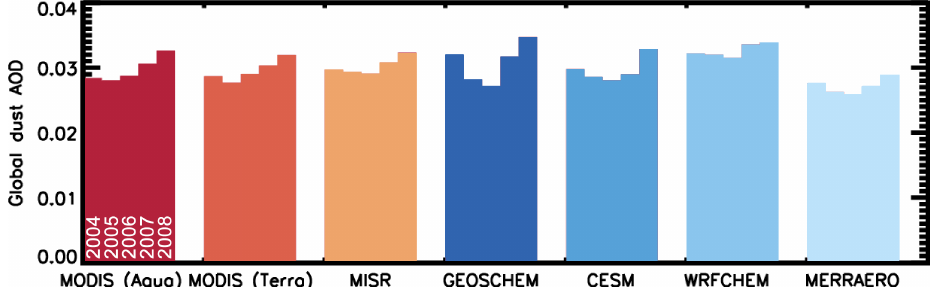
Figure 4. Annual global dust AOD for 2004–2008 derived from the three satellite instruments (red hues) and from the four models (blue hues). The annual dust AOD from the satellite instruments is an average of the ensemble members for that